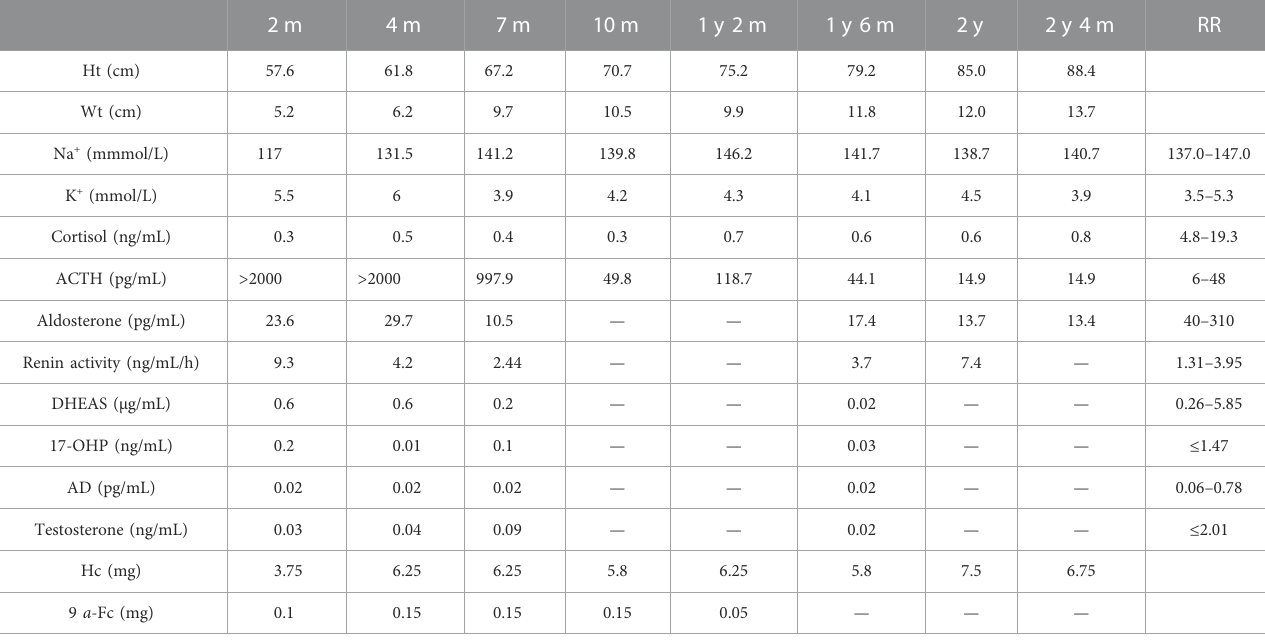
TABLE 1 Clinical data of the patient with LCAH before and after